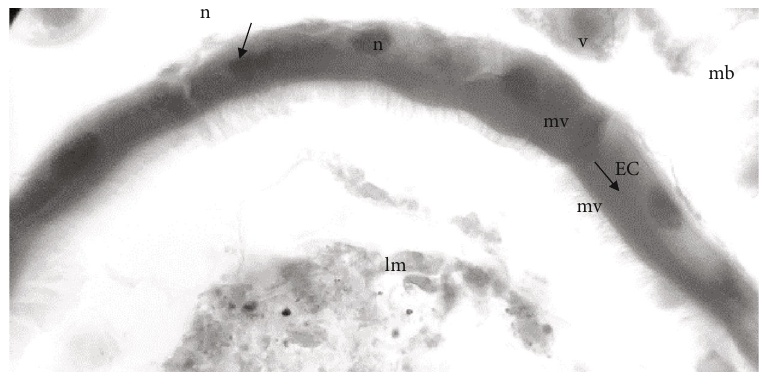
Figure 2: Cross-section histopathology of the midgut of the control group showing epithelial cells (EC) with microvilli